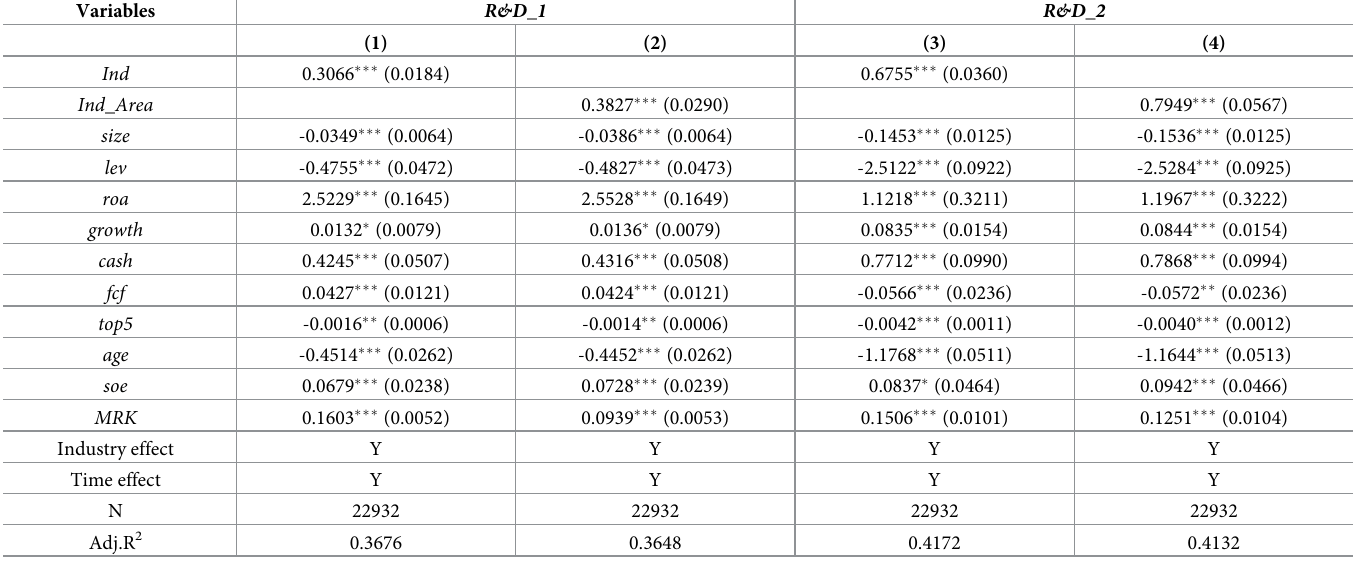
Table 5. CEO awards and R&D investment by